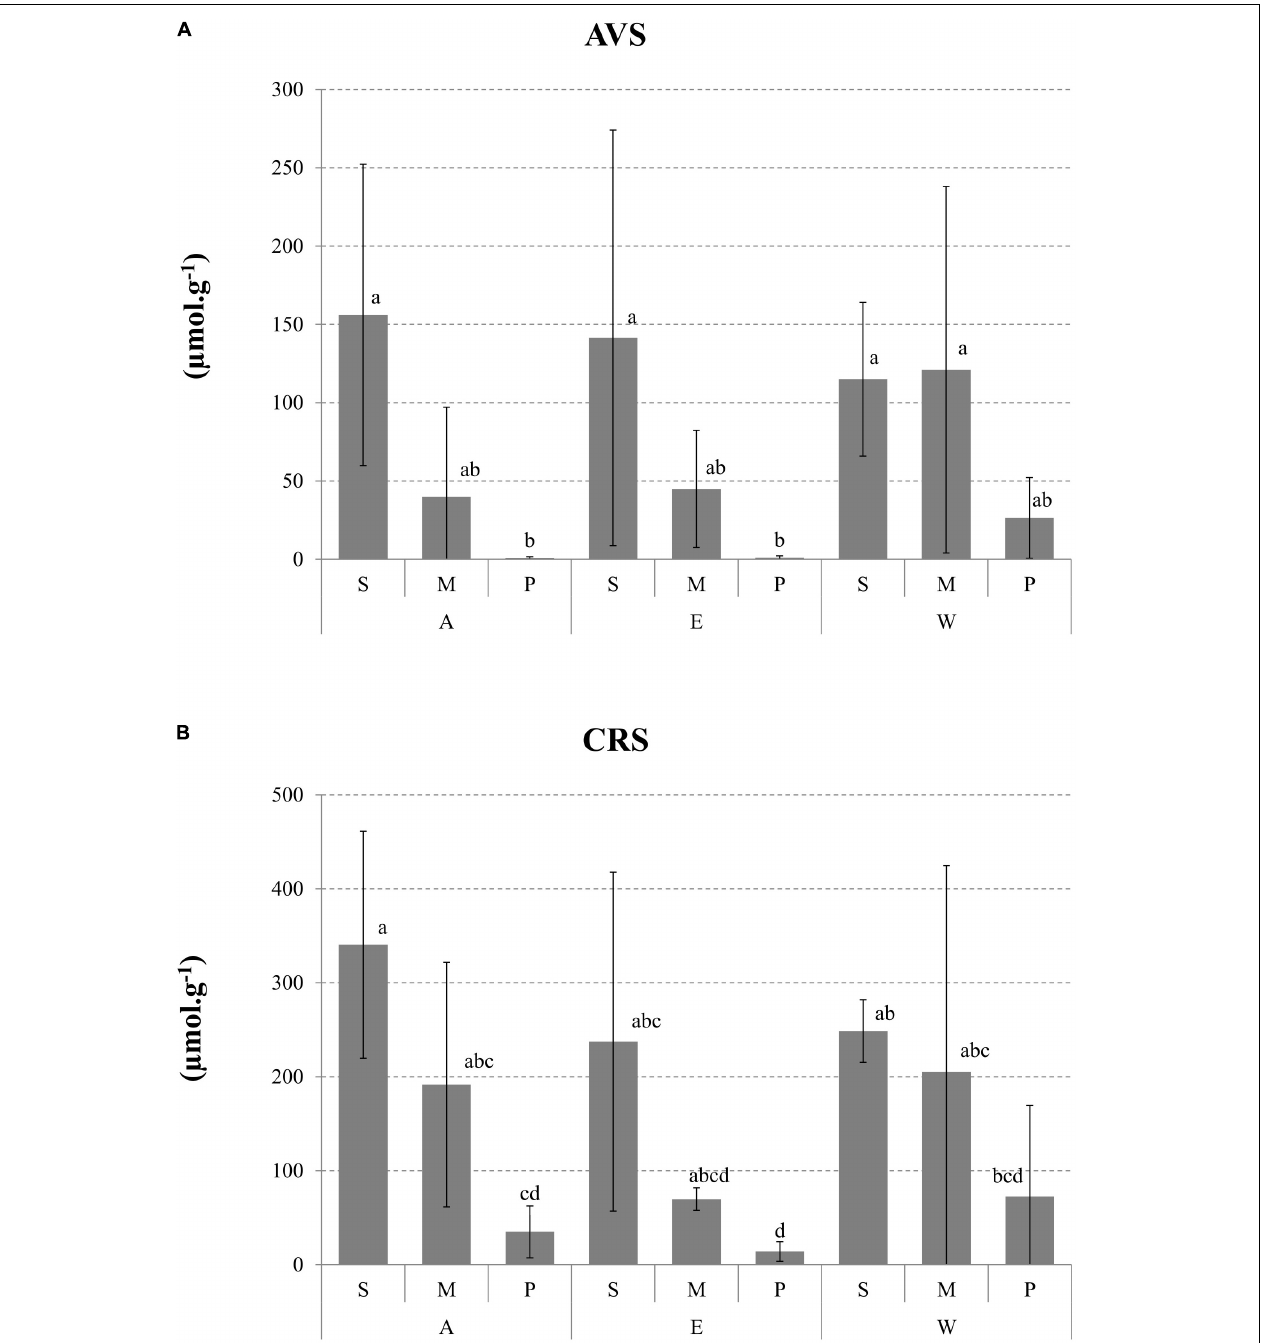
FIGURE 5 | Depth profiles of (A) acid volatile sulfides (AVS) and (B) chromium reducible sulfur (CRS) given in µ mol g - 1 dw. AVS and CRS are the average of three cores ( ± SD). Lower case letters show the groups of ponds differentiated by the Dunn’s multiple comparison test following a significant non-parametric Kruskal–Wallis